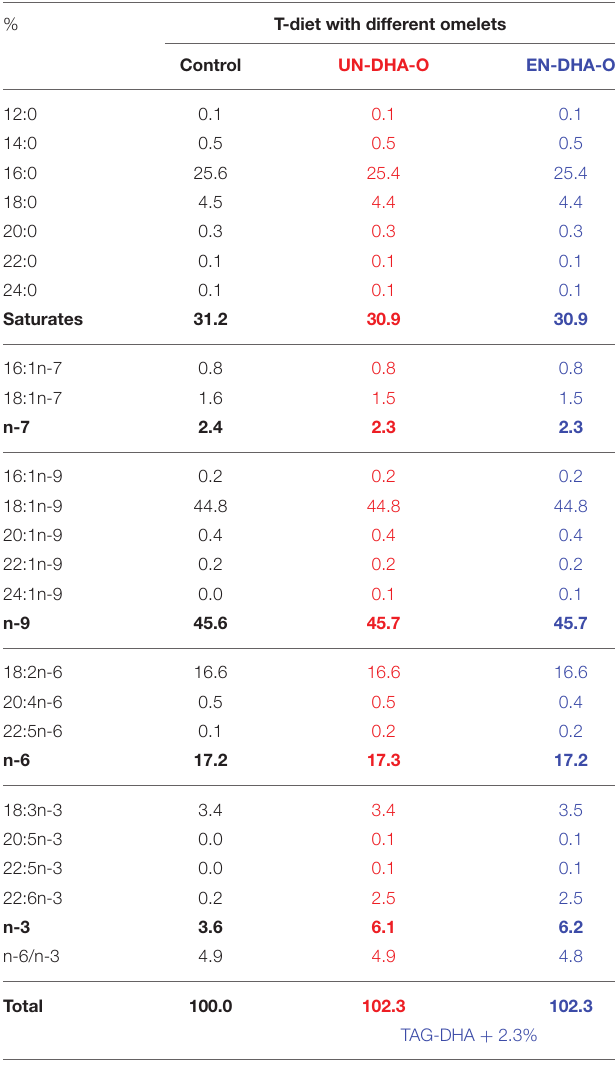
The fatty acid profile was calculated per group of omelets on the base of the treatment diet consumption, and was averaged per day on the four-week experimental period. This profile corresponds to the combination between FA consumed from the T-diet and FA supplied by the 3g omelet. Bold values correspond to the sum of fatty acids per family. Colored values correspond to the type of omelets: black for control, red for UN-DHA-O and blue for